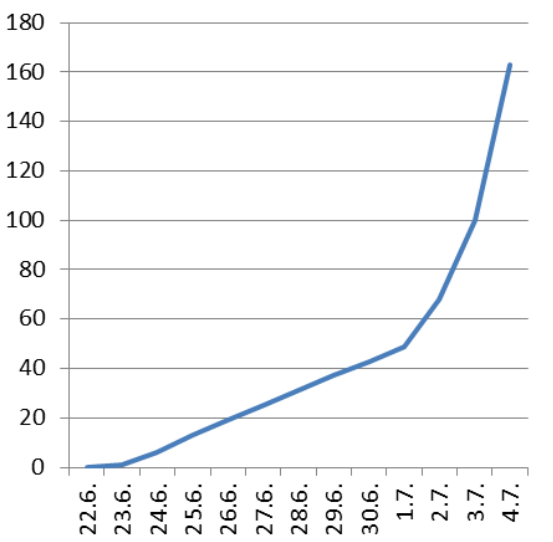
Figure 4 Estimation of pea aphid population growth according to preliminary test.